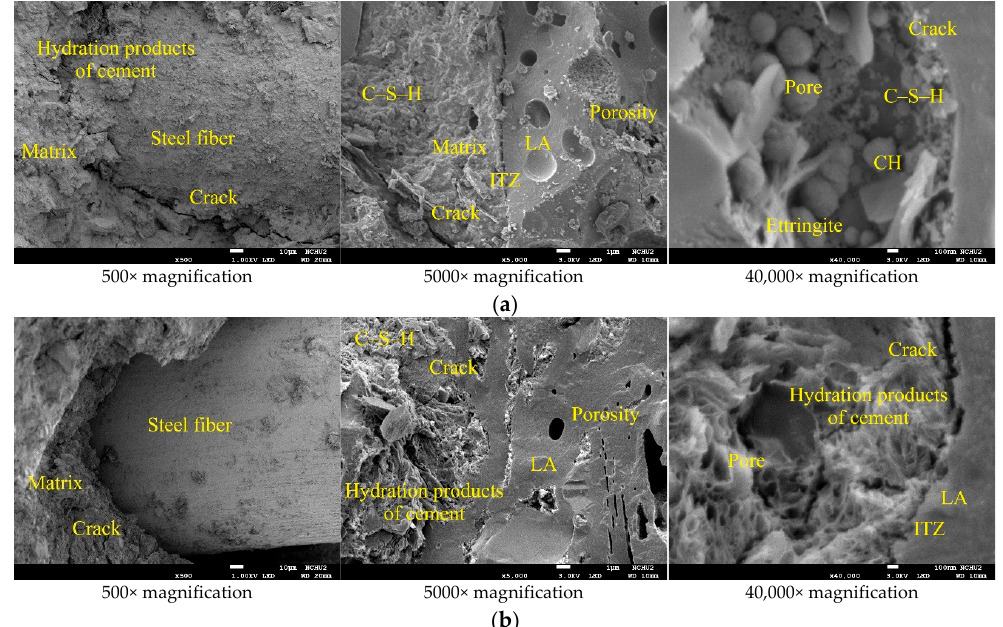
Figure 13. SEM micrographs of the concrete specimens after self-healing for 28 days: ( a ) control group; ( b ) experimental group.